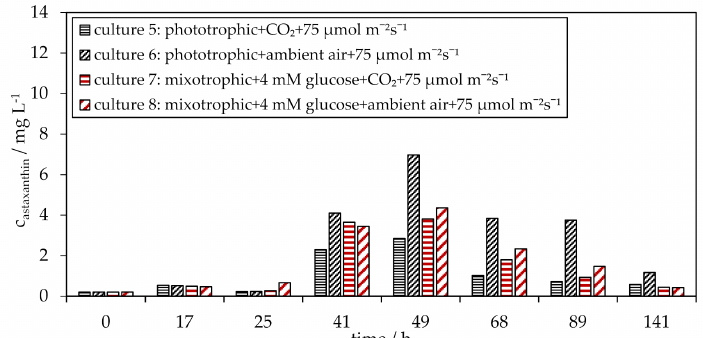
Figure 4. Astaxanthin concentration in the ethyl acetate extract of the phototrophic culture 5 (pho- totrophic + CO 2 + 75 µ mol m − 2 s − 1 ) and culture 6 (phototrophic + ambient air + 75 µ mol m − 2 s − 1 ), and mixotrophic culture 7 (mixotrophic + 4 mM glucose + CO 2 + 75 µ mol m − 2 s − 1 ) and culture 8 (mixotrophic + 4 mM glucose + ambient air + 75 µ mol m − 2 s − 1 ) at different time points after the start of germination; data obtained by single determination.